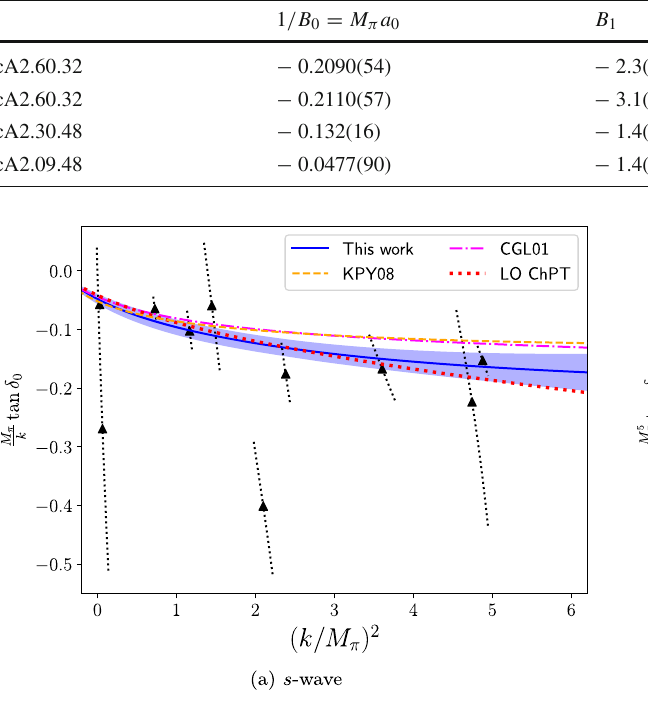
= M 2 π . Here we use only the two-pion levels in the A 2